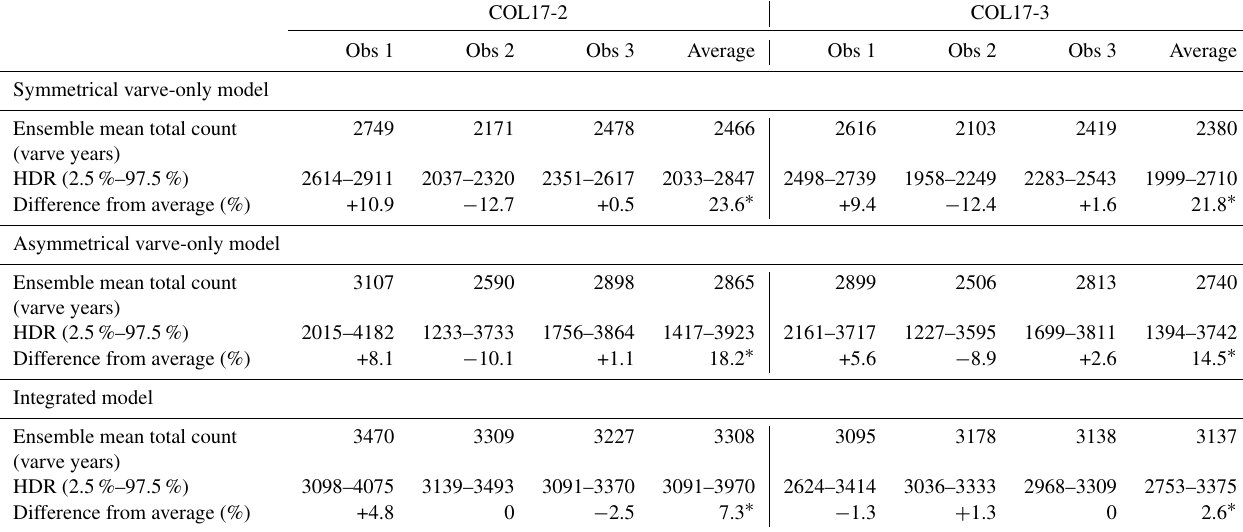
Table 2. Comparison of observer- and core-specific varve ages based on the symmetric and asymmetric varve-only model as well as the integrated model. HDR: highest probability density region.